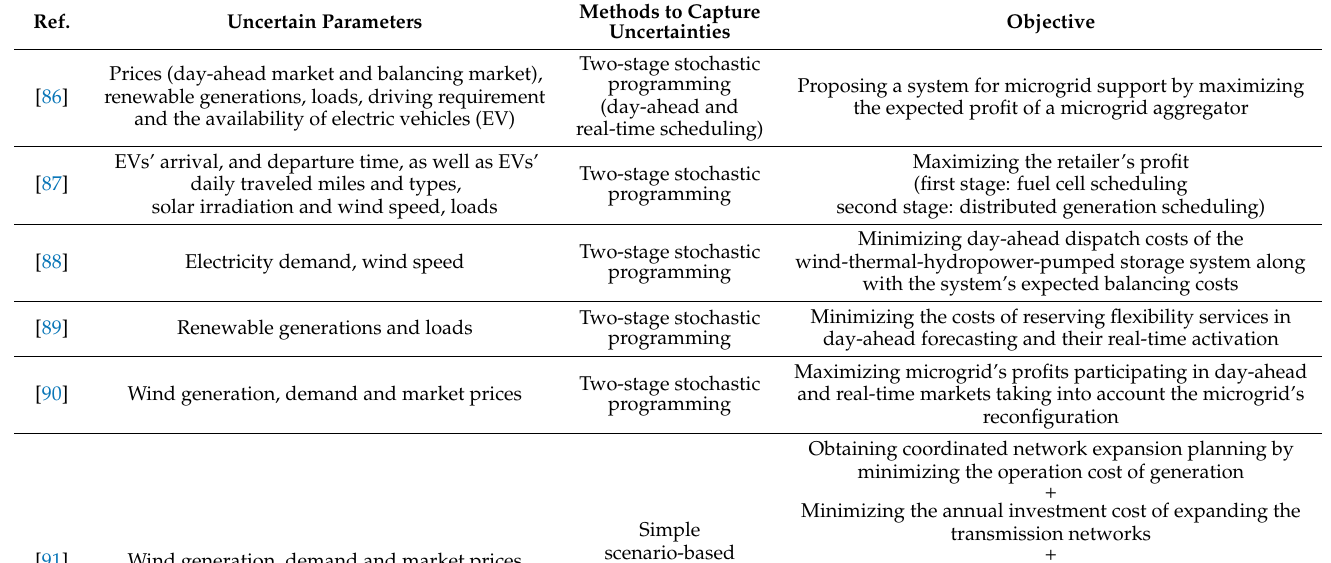
Table 6. An overview of recent papers using stochastic programming for decision making in a smart grid